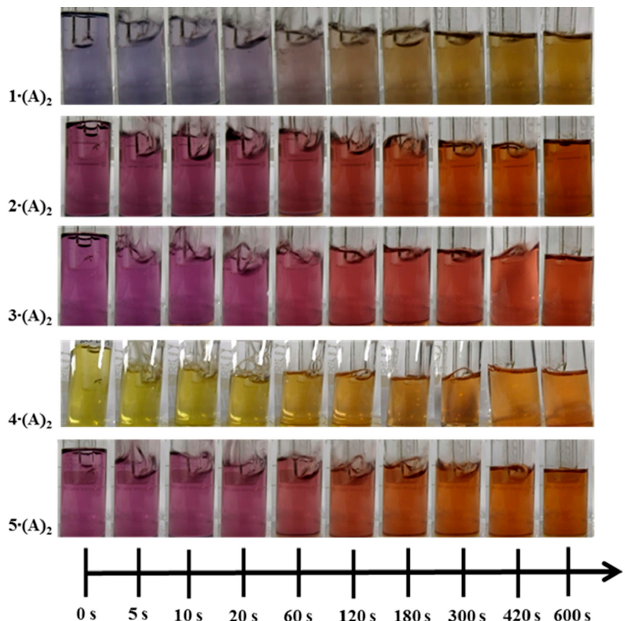
Figure 5. Color changes of the rhodium complexes 1 ∙ (A) 2 – 5 ∙ (A) 2 dissolved in toluene, during the exposure to 100 ppm CO (40% r.H.) for 10 min.